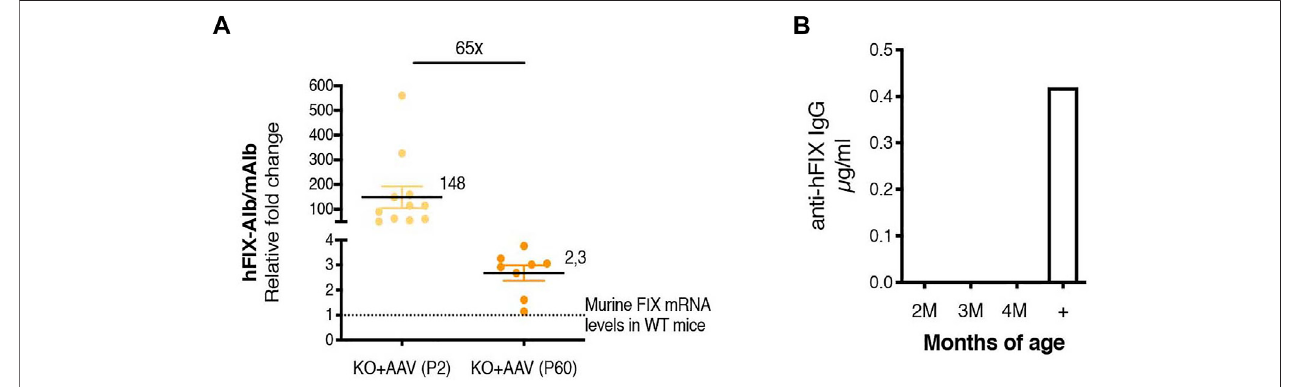
FIGURE 7 | Chimeric Alb-hFIX mRNA expression levels in mice treated at P2 and P60 and evaluation of anti-hFIX neutralizing antibodies. (A) Analysis of hybrid Alb-hFIX mRNA expression levels. Alb-hFIX mRNA expression was evaluated in both treated groups (P2, n = 10, and P60, n = 8) and endogenous mFIX mRNA was analyzed in wild-type mice. The fold-increase between hFIX in treated mice and endogenous mFIX in WT mice is indicated; (B) Anti-hFIX neutralizing antibodies were measured using an ELISA assay. Mice plasma was analyzed at different time-points by incubation with hFIX recombinant protein. An anti-hFIX antibody was used as a positive